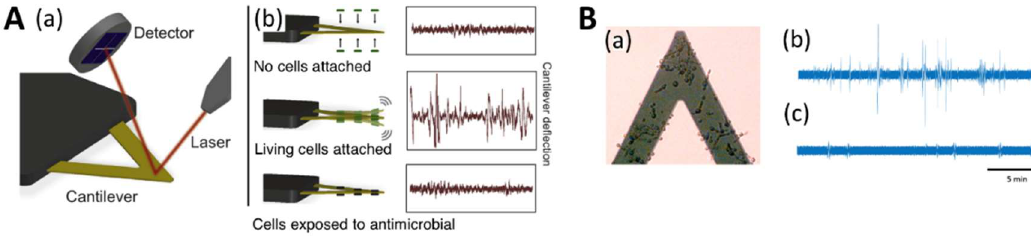
Figure 2. ( A ) Outline of experimental setup and description of experiments. ( a ) Schematics of nanomotion detector setup with a cantilever sensor; laser beam is focused on the surface of the sensor and reflection is used to monitor movements of the cantilever. ( b ) Representation of a typical nanomotion susceptibility test. When microorganisms are not attached to the sensor, fluctuations are driven only by thermal motion and are relatively low. After attachment of living cells, fluctuations are linked to their metabolic activity and are high. Finally, after exposure to an antimicrobial drug, the cells are nonviable and fluctuations return to low levels. Reprinted with permission from